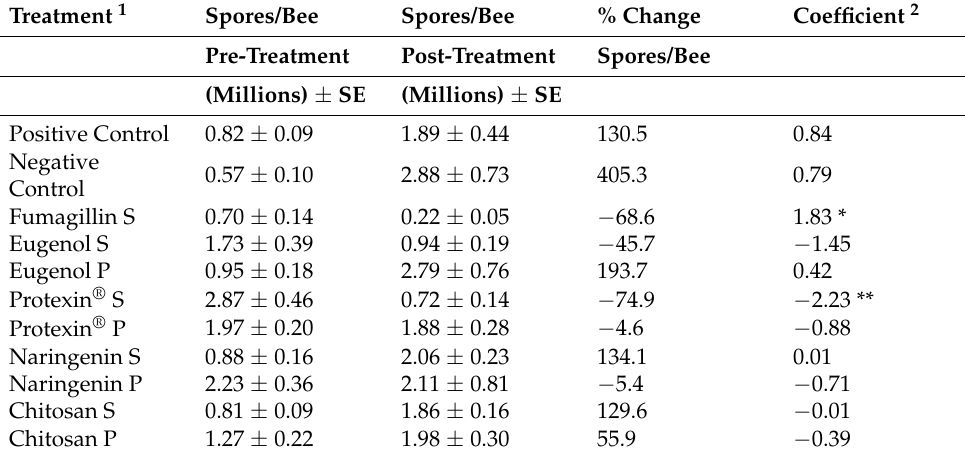
Table 4. Effect of fall 2017 treatments on N. ceranae spore counts per bee one-two days pre-treatment and three weeks post-treatment with the antibiotic fumagillin, prebiotics eugenol, naringenin or chitosan, or probiotic Protexin ® . Coefficients indicate how the log of spores per bee changed relative to the positive control. Means are from 100 bees in six colonies per treatment.